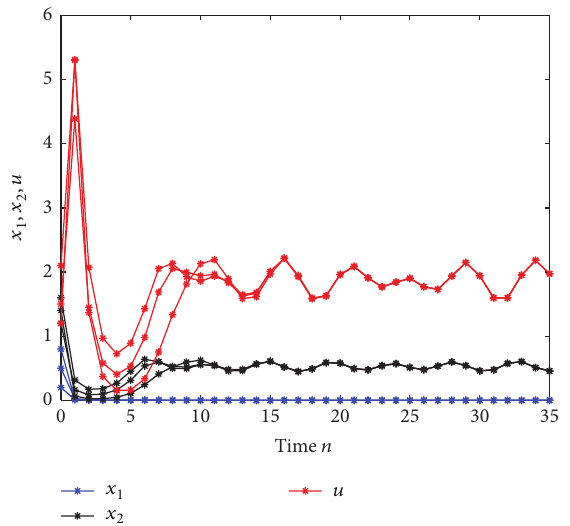
Figure3:Dynamicbehaviorsofthesolution (𝑥 1 (𝑛),𝑥 2 (𝑛)) ofsystem (110), with the initial conditions (𝑥 1 (𝑠),𝑥 2 (𝑠)) = (0.8,0.4) , (1.4, 1.2) , and (1.2, 1.0) , 𝑠 = ⋅⋅⋅ ,−𝑛,−𝑛 + 1, ...,−1,0 ,